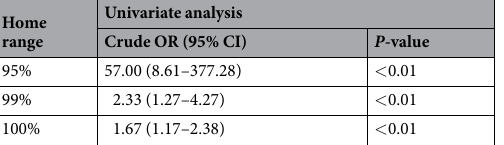
Table 2. Relationship between presence of H5N1 cases and the home range of whooper swans at Sanmenxia